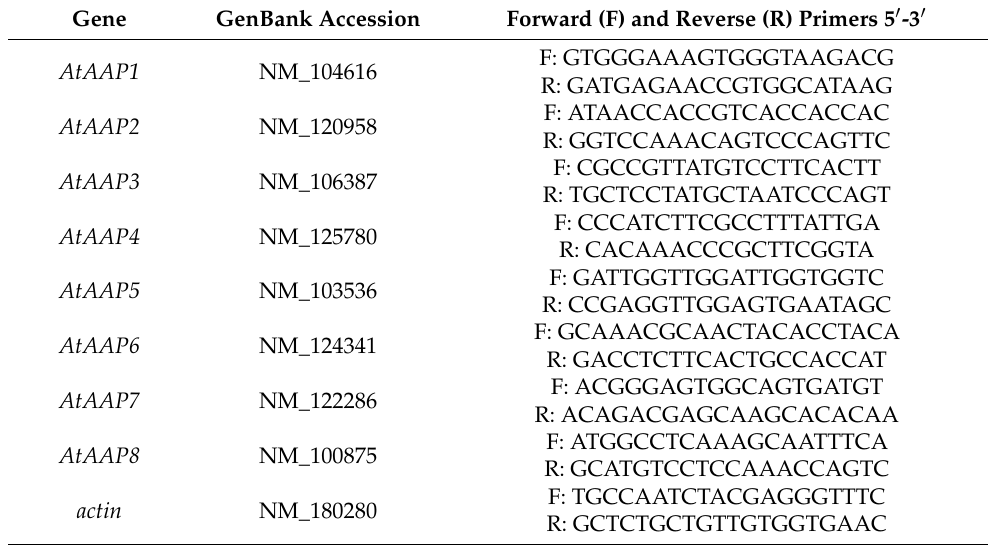
Table 2. DNA sequences of primers used for the quantitative expression analysis based on the quantitative real-time PCR (qRT-PCR) of eight AtAAP genes and the internal reference gene actin in Arabidopsis thaliana